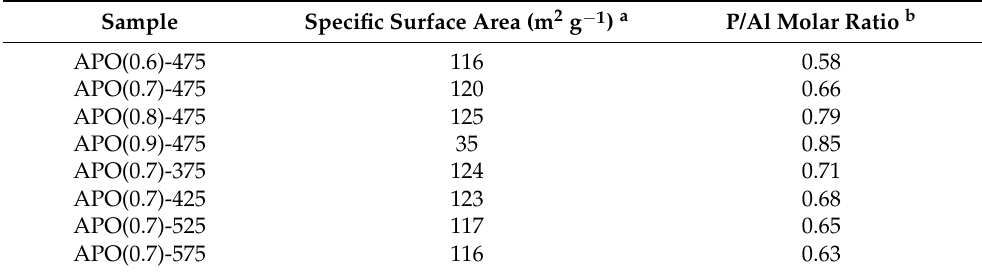
Table 1. Physico-chemical characteristics of APO catalysts.